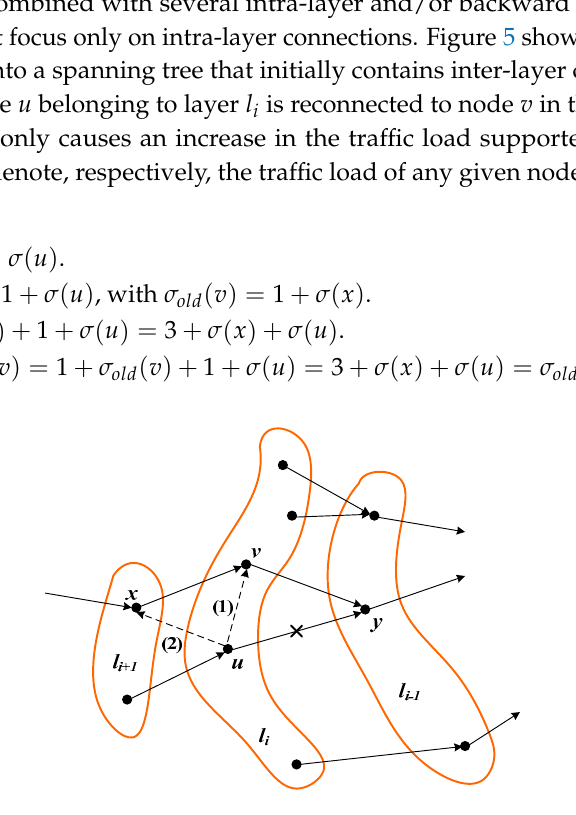
Figure 5. Converting an inter-layer connection into an intra-layer (1) or a backward inter-layer (2) connection. (2)